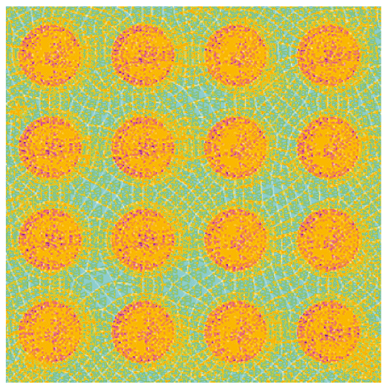
Figure 25: Temperature load loading model.